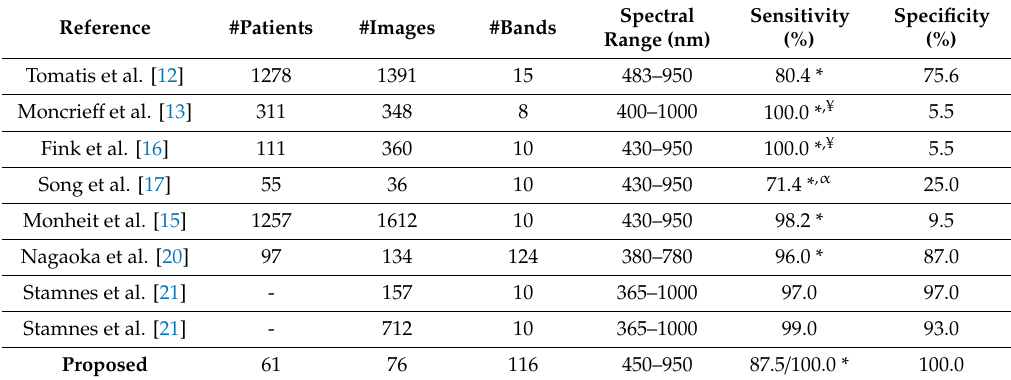
Table 4. Comparison of the obtained results with the